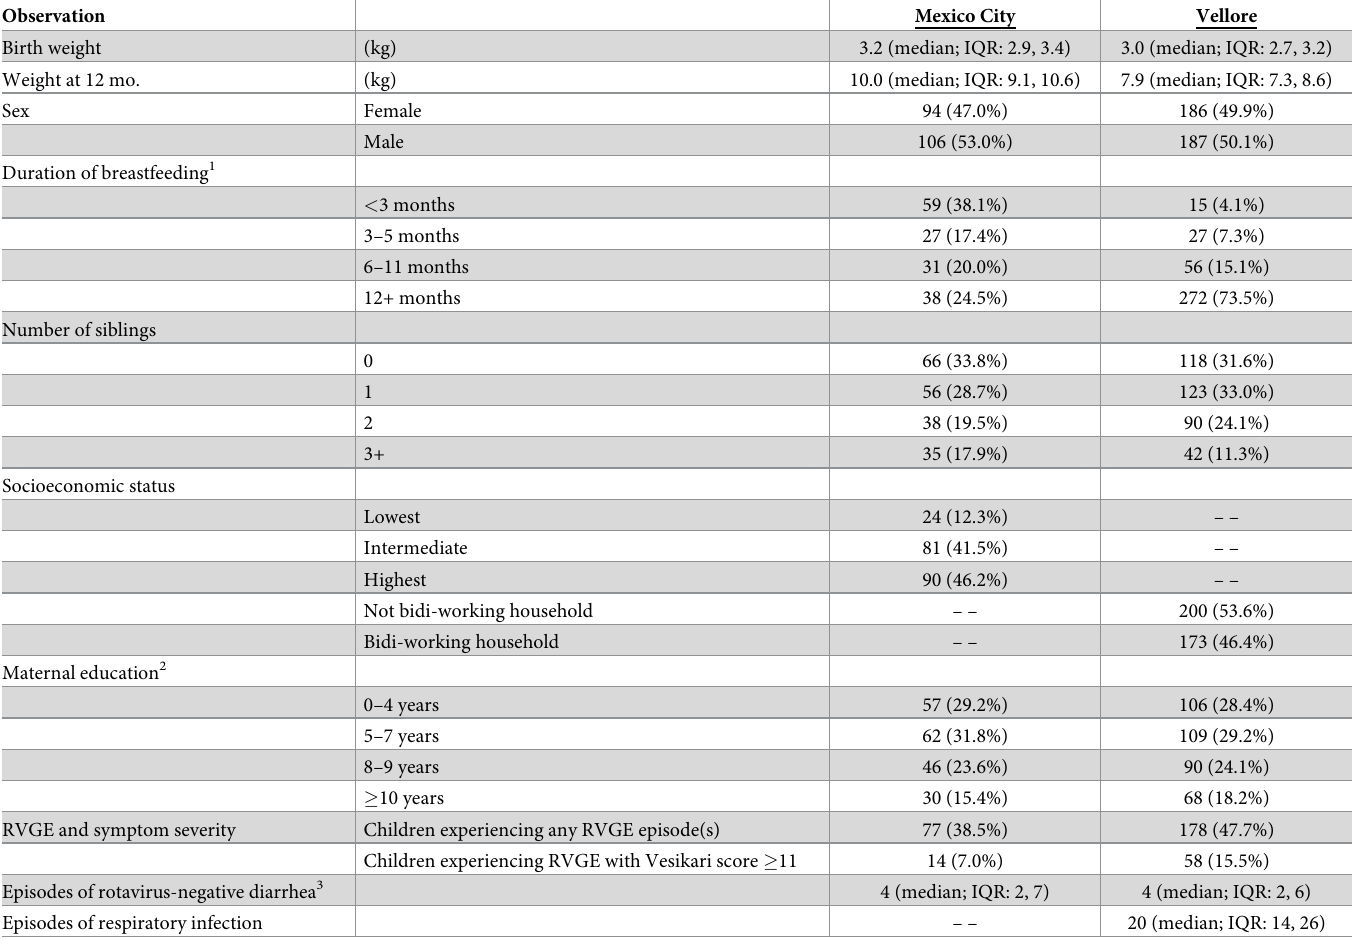
Table 2. Characteristics of the two